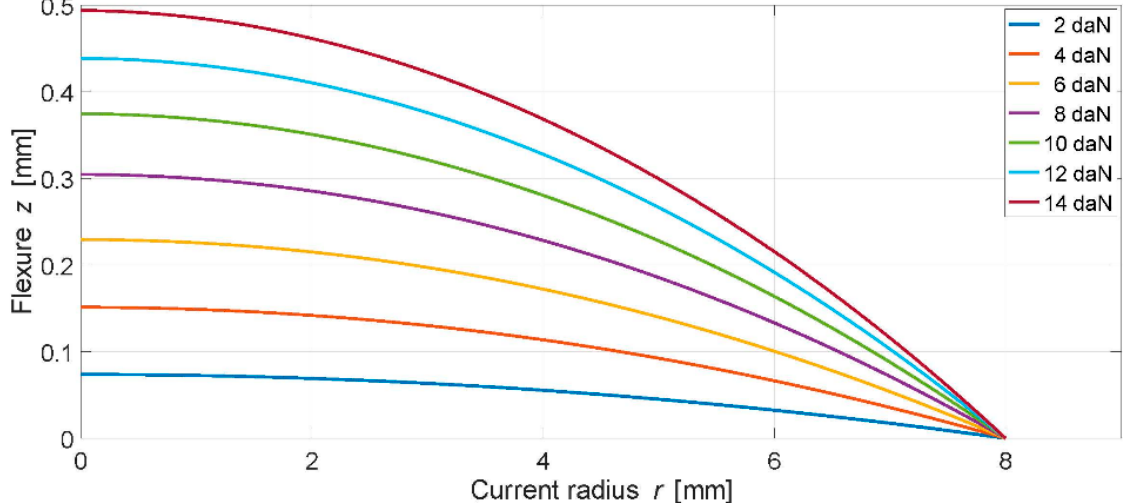
Figure 3. Flexures vs. current radius for tulip ‐ like VCM. Thickness T = t / t 0 = [ − ln( ρ ) 2 ] 1/3 for 0.0125 < ρ < 0.95 and t 0 = 300 μ m. Truncated central thickness t c = 618 μ m for ρ < 0.0125. Conical thickness for ρ > 0.95 with t ( ρ = 1) = 100 μ m.